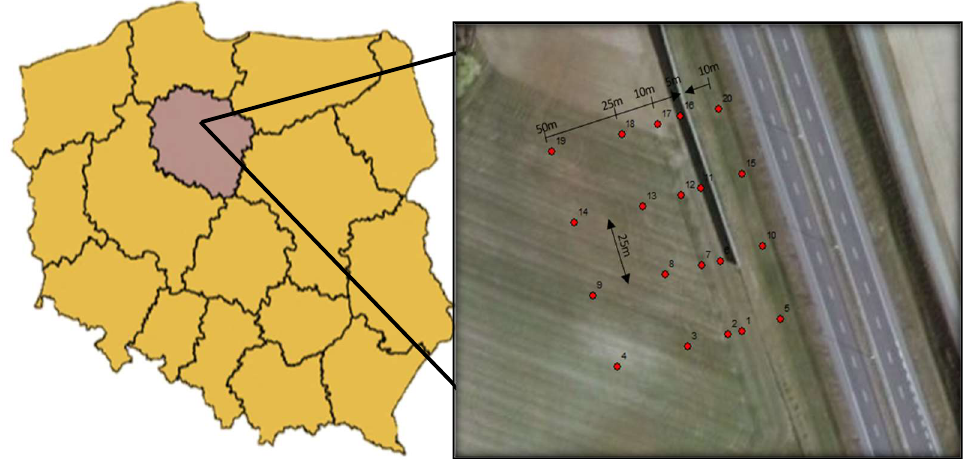
Figure 1. Study area.